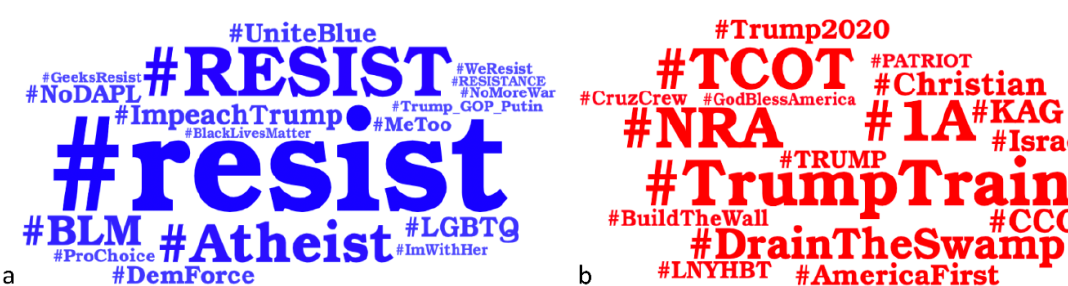
Figure 4. Most common hashtags appearing in the profile descriptions of (a) left-leaning users, and (b) right-leaning users. Font size is proportional to the number of occurrences across